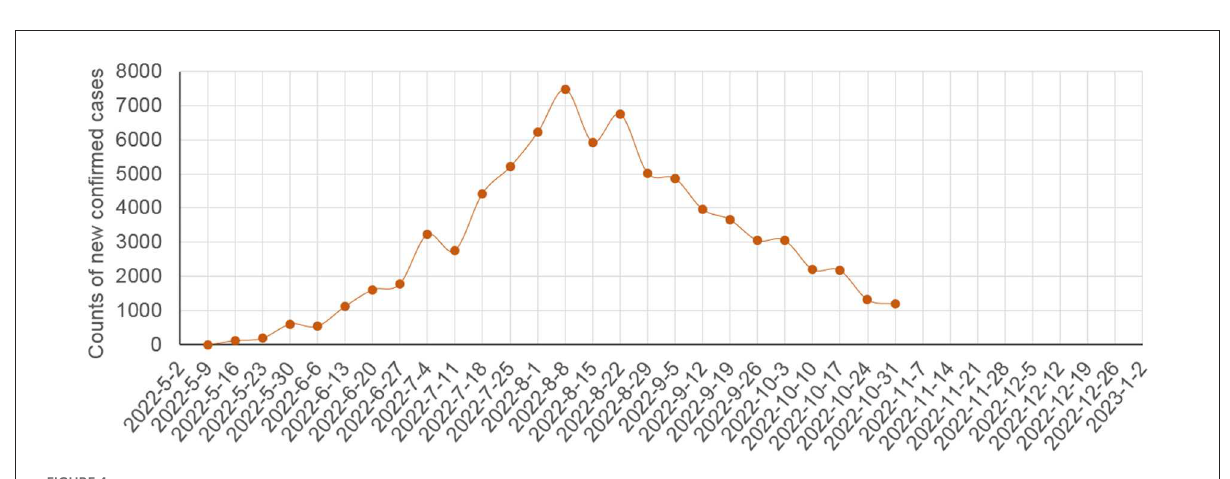
FIGURE4 Counts of global weekly new confirmed human MPX cases in the 2022 outbreak as per the data from the WHO